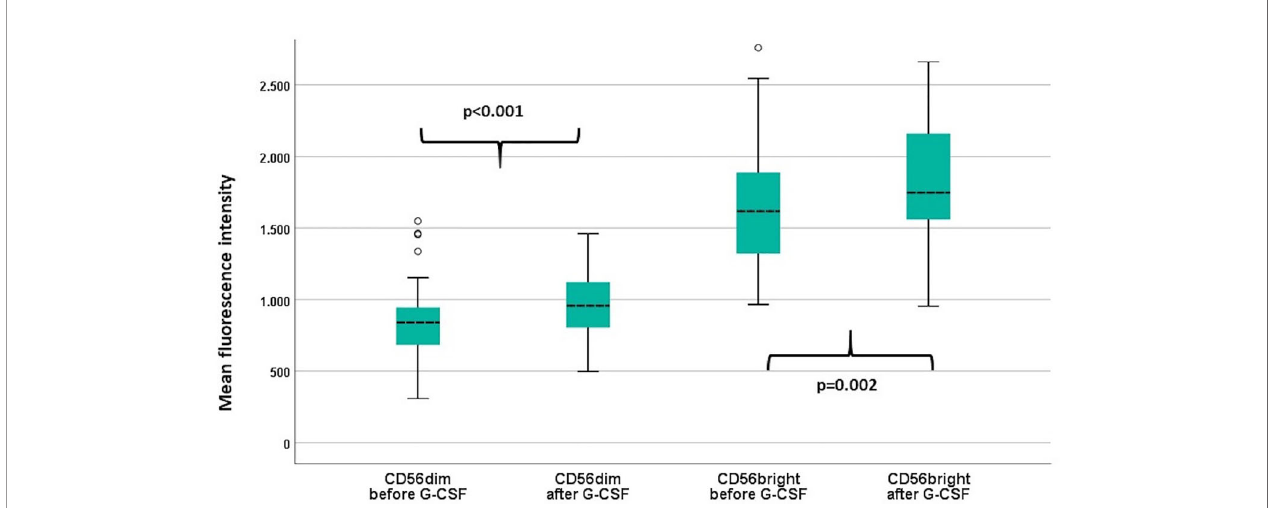
FIGURE 3 | Mean fl uorescence intensity (MFI) of NKG2D in the CD56dim and the CD56bright NK cell subsets before and after G-CSF stimulation in peripheral blood of healthy donors, n=49. P-values from paired samples T-test. Boxes represent interquartile range. Whiskers represent minimum and maximum values. Circles represent outliers (1.5 times larger/smaller than the third/ fi rst